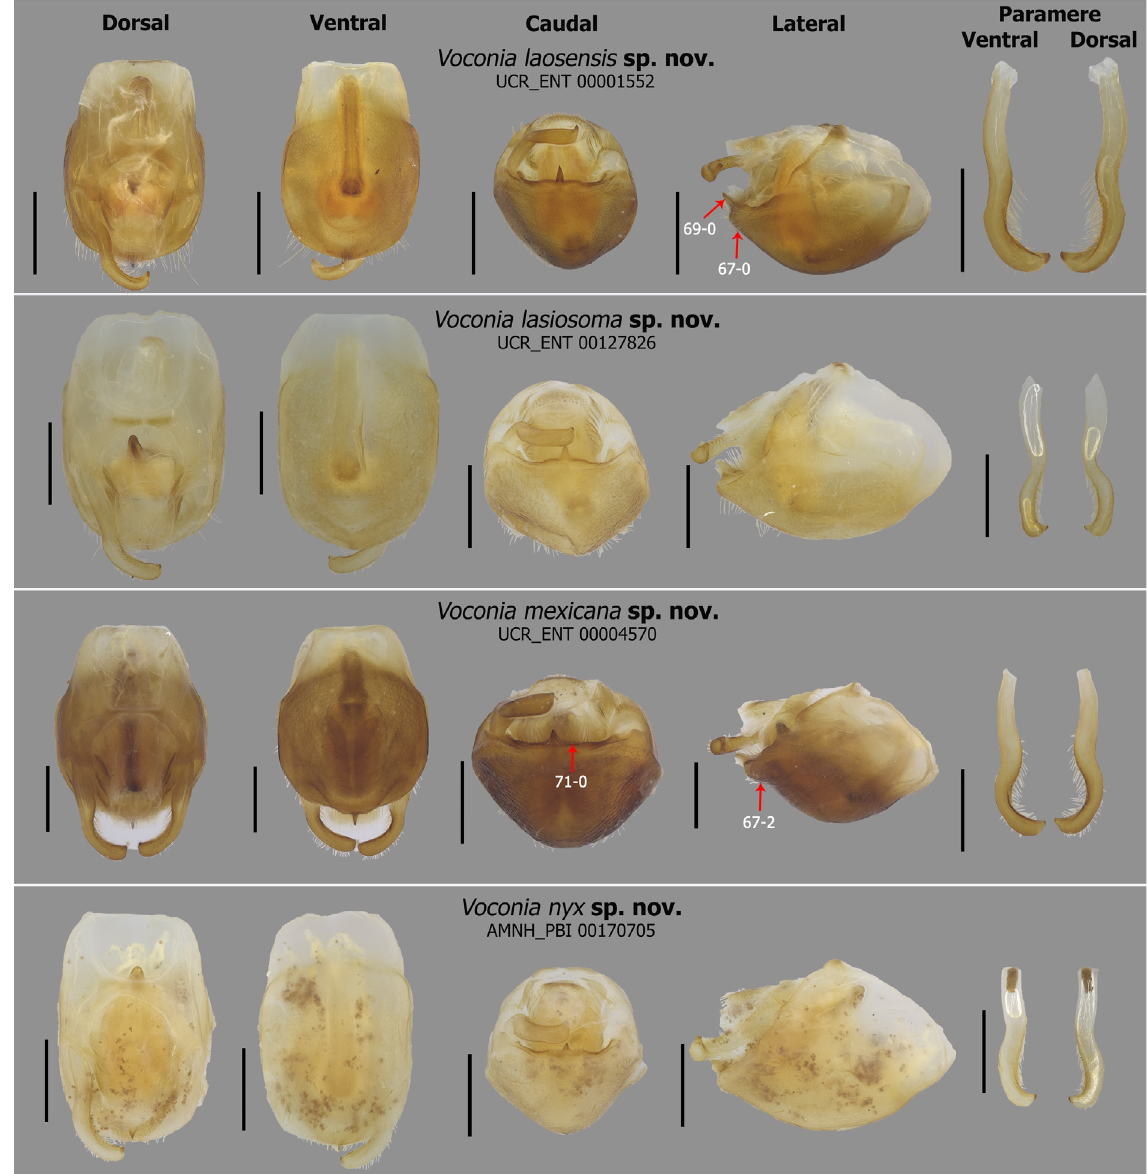
Fig. 12. Pygophore of species of Voconia Stål, 1866. Scale bars = 0.5